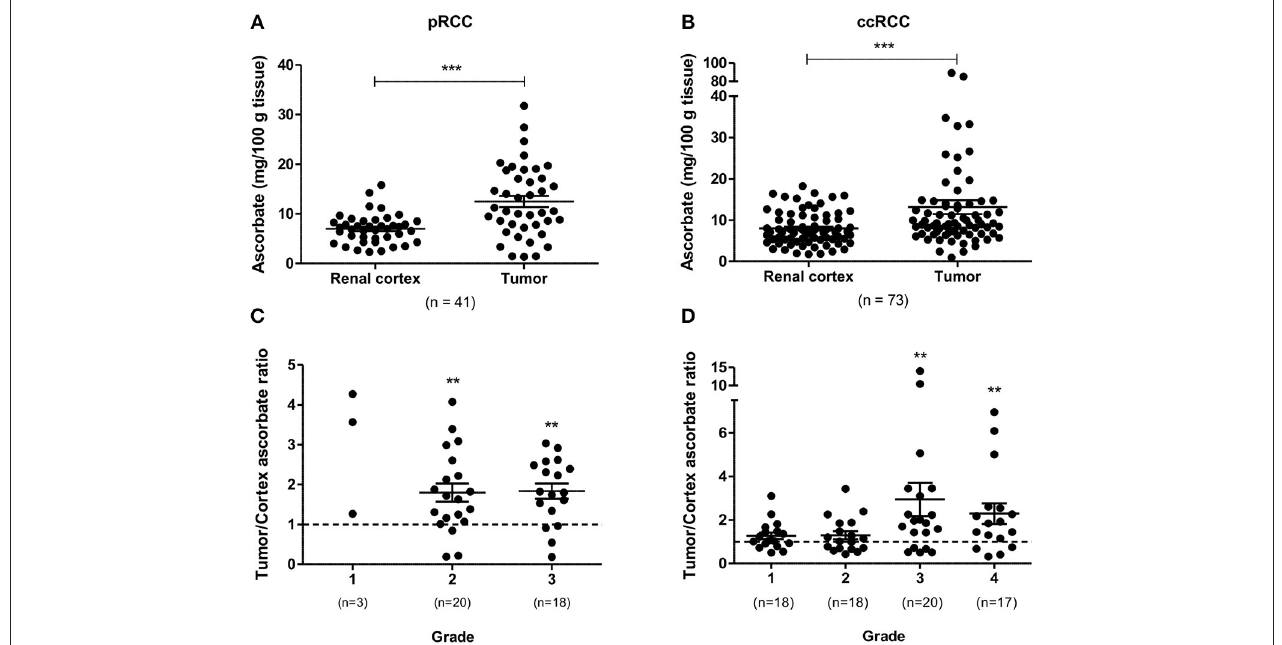
FIGURE 1 | Ascorbate content of pRCC and ccRCC samples compared to renal cortex tissue. Tumor ascorbate levels are increased compared to renal cortex of the same patient for both pRCC ( n = 41) and ccRCC ( n = 73) as determined by Wilcoxon matched-pairs signed rank test (A,B) . Tumor to renal cortex ascorbate ratio by Fuhrman grade (C,D) . Tumor ascorbate content is significantly higher than matched renal cortex in Fuhrman grade 2 and 3 pRCCs and grade 3 and 4 ccRCCs (Wilcoxon signed rank test). Error bars represent mean ± SEM; ** p < 0.01, *** p < 0.001.